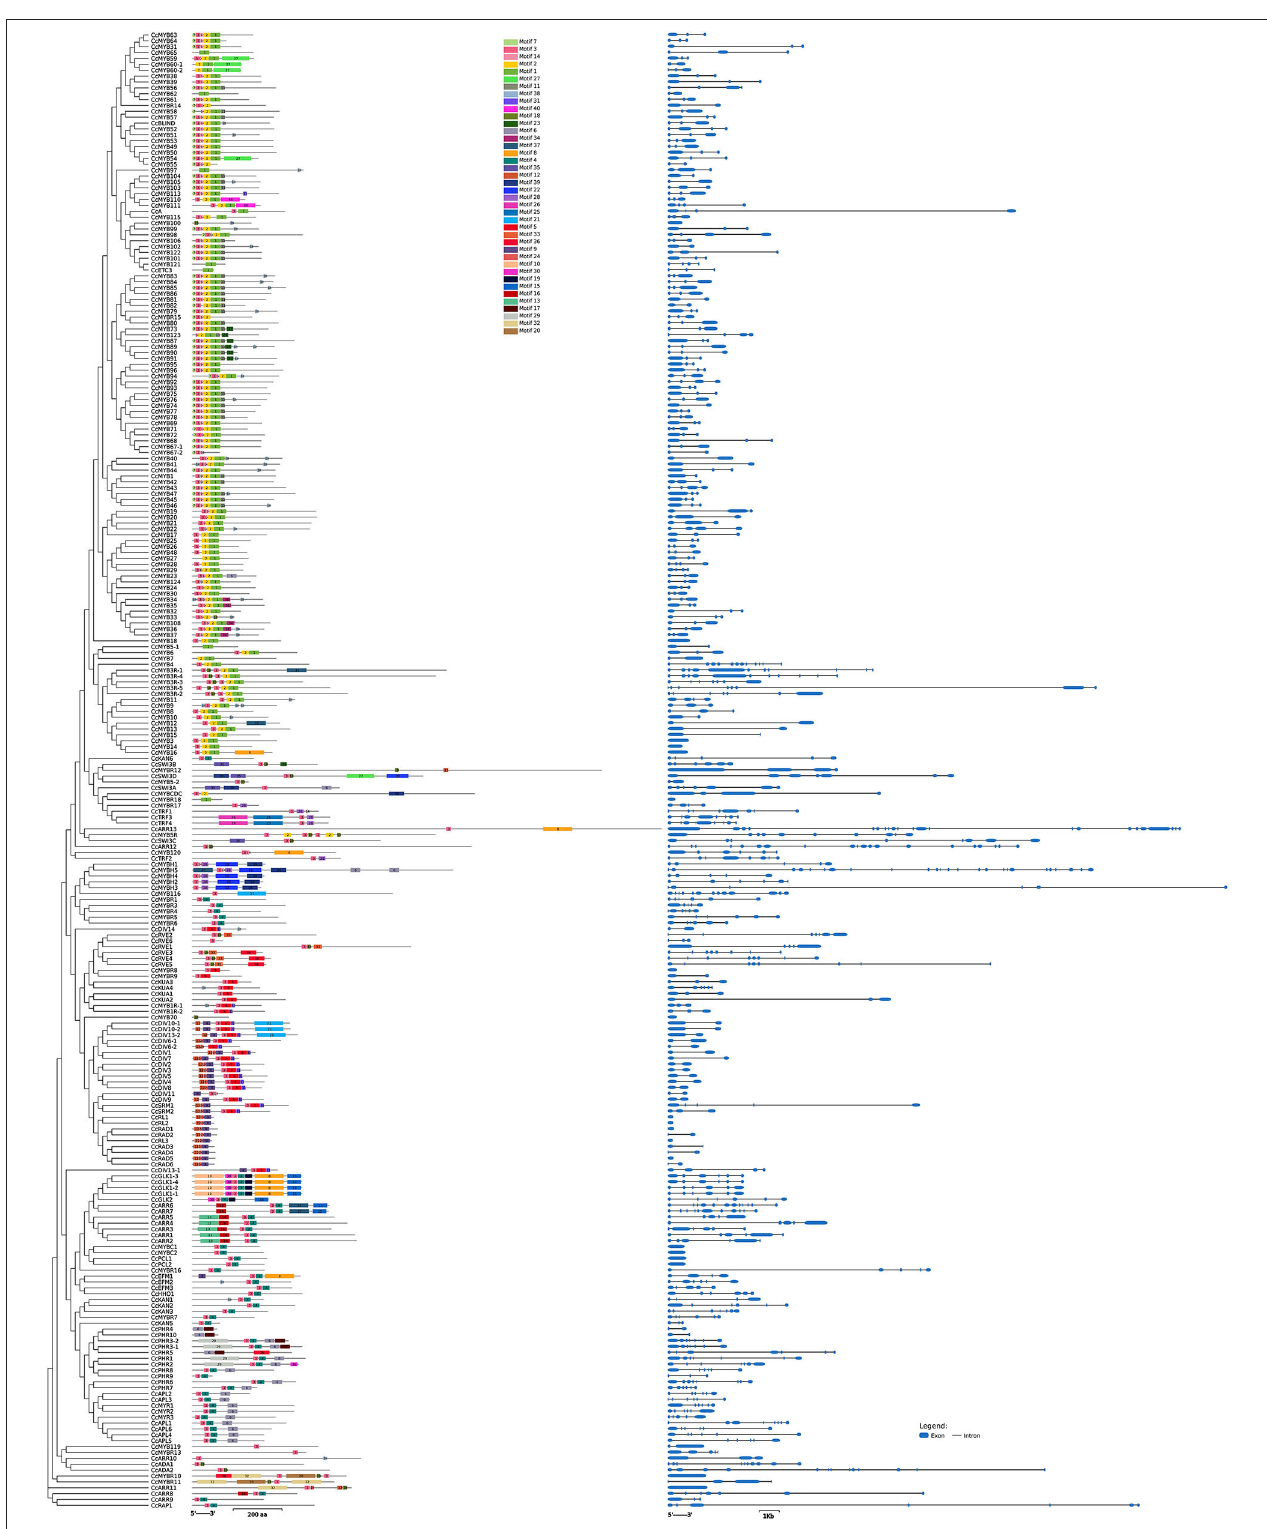
FIGURE 2 | Conserved amino acid motifs and structure of CcMYB genes. The motifs are differently colored with a specific number. The exons are shown in blue blocks, while the connecting lines in between represent intronic regions in kb (kilobase).